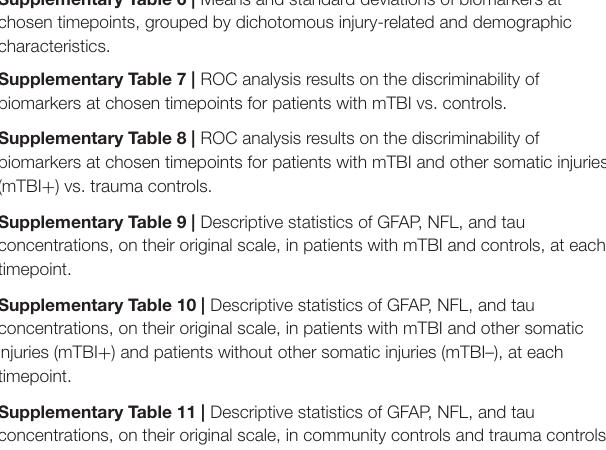
variables listed at the top of the table as possible predictors.